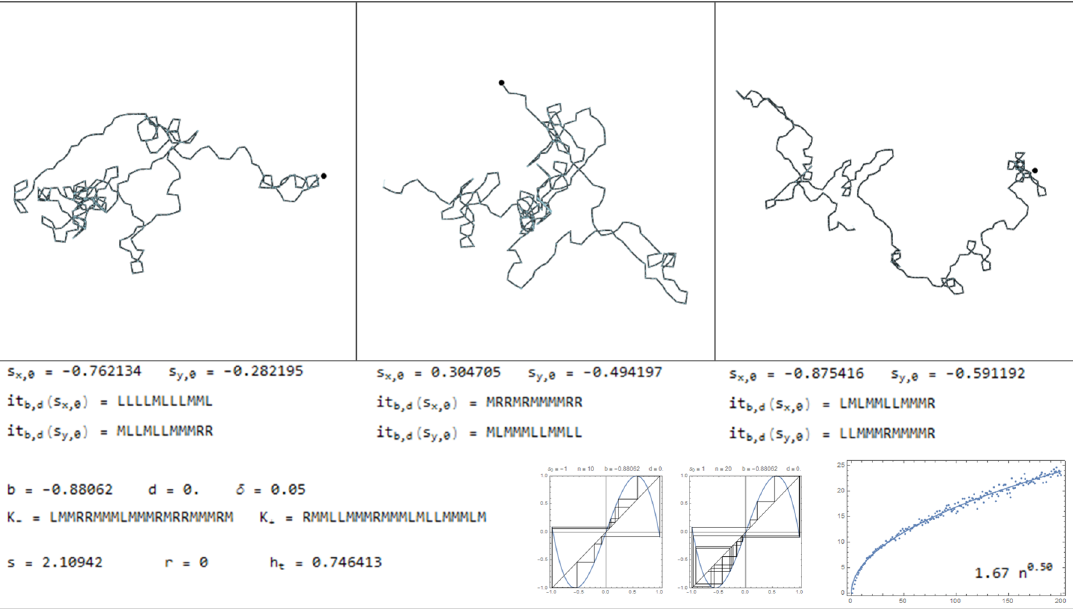
Figure 22. Trajectories produced with b = − 0.88062 and d = 0.